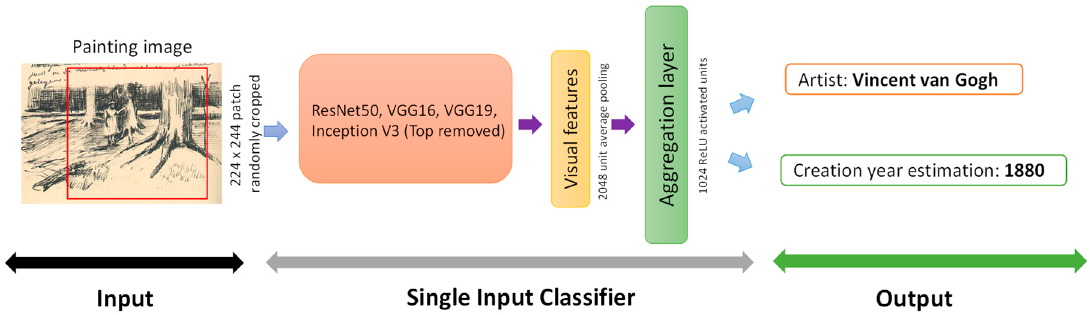
Figure 8. Single input network.